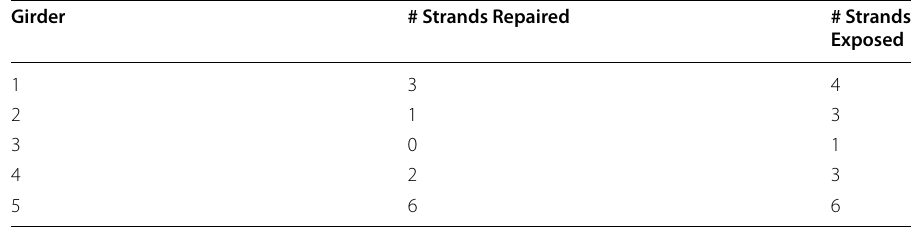
Table 1 The number of strands exposed and repaired in each girder Girder # Strands